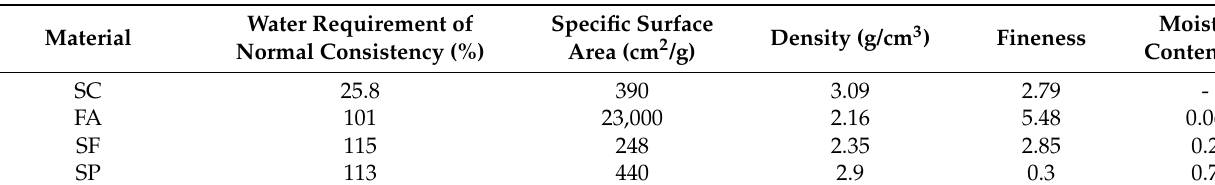
Table 2. Physical properties of gelling materials.